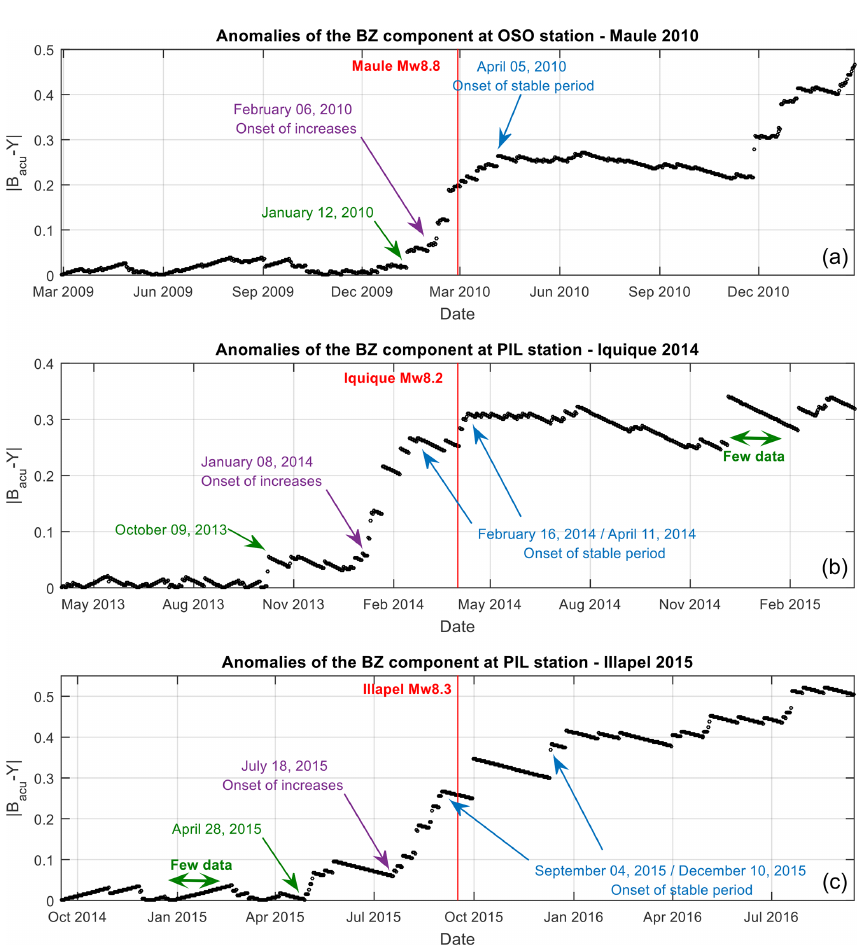
Figure 8. Variation in the accumulated diary of magnetic anomalies of B z during 2 years close to the three earthquakes: (a) Maule, (b) Iquique, and (c) Illapel. The data were taken at OSO station (a) and PIL station (b, c) , respectively. Is clear that the sigmoidal shape is similar in all of the earthquakes. This means that these stations recorded a dramatic increase in the number of magnetic anomalies between 50 and 90d prior to each